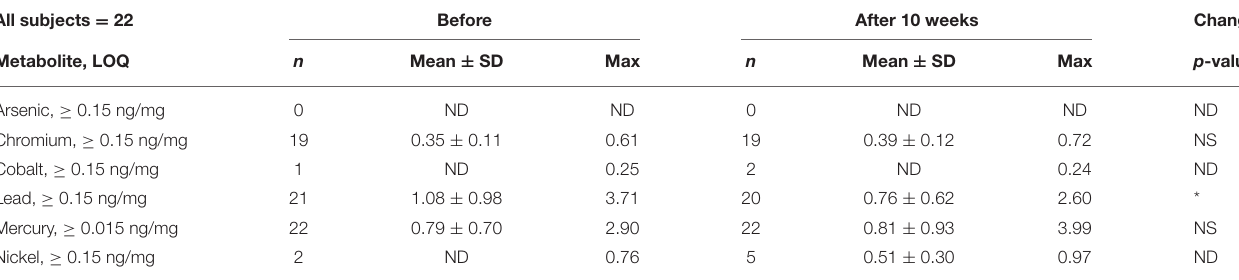
TABLE 3 | Environmental pollutants in hair before the 10-days fasting period and 10 weeks